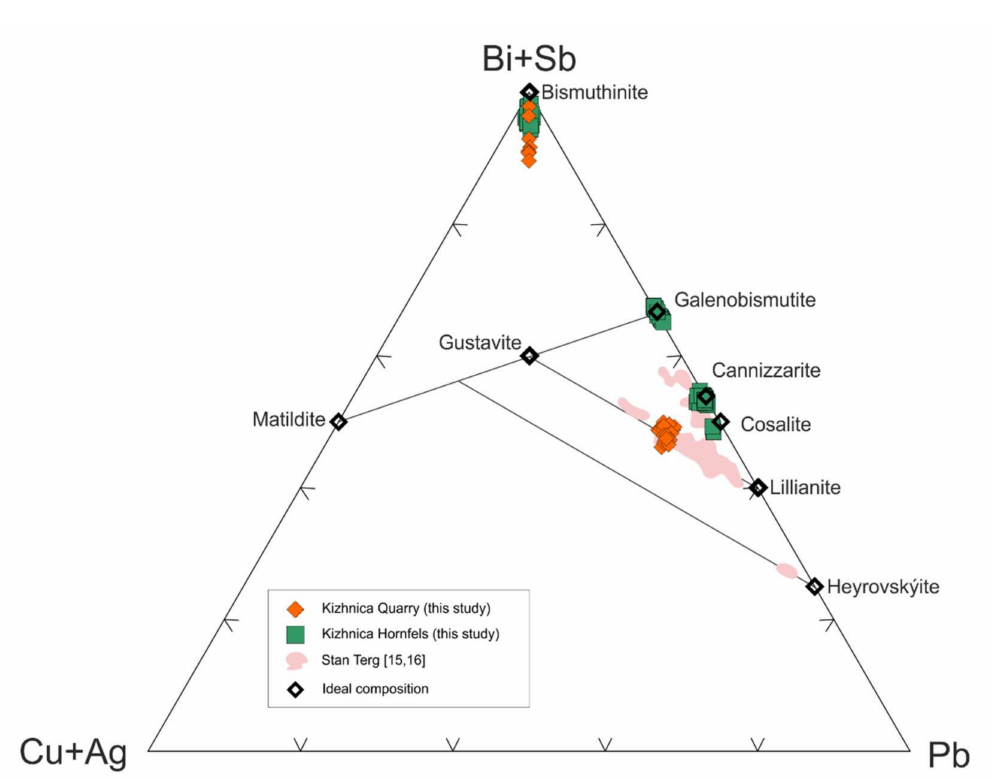
Figure 7. Ternary plot Cu + Ag vs Bi + Sb vs Pb of bismuth sulfosalts from the Kizhnica area and the Stan Terg deposit